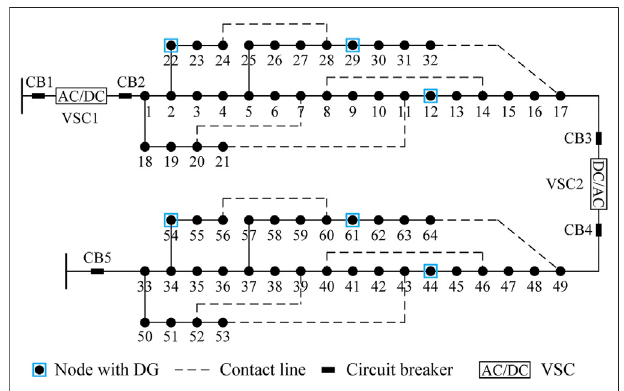
FIGURE 1 | Topology of AC/DC hybrid distribution